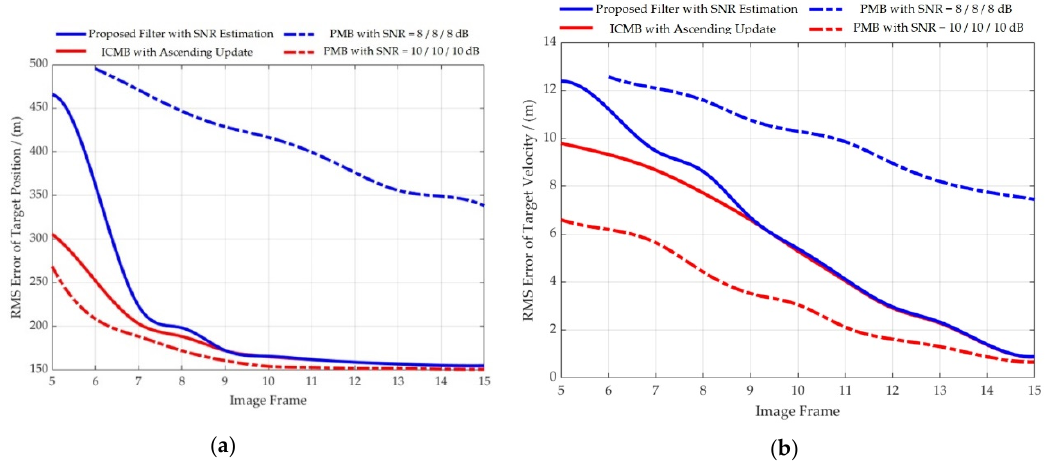
Figure 13. Comparison results of detected frame rate.